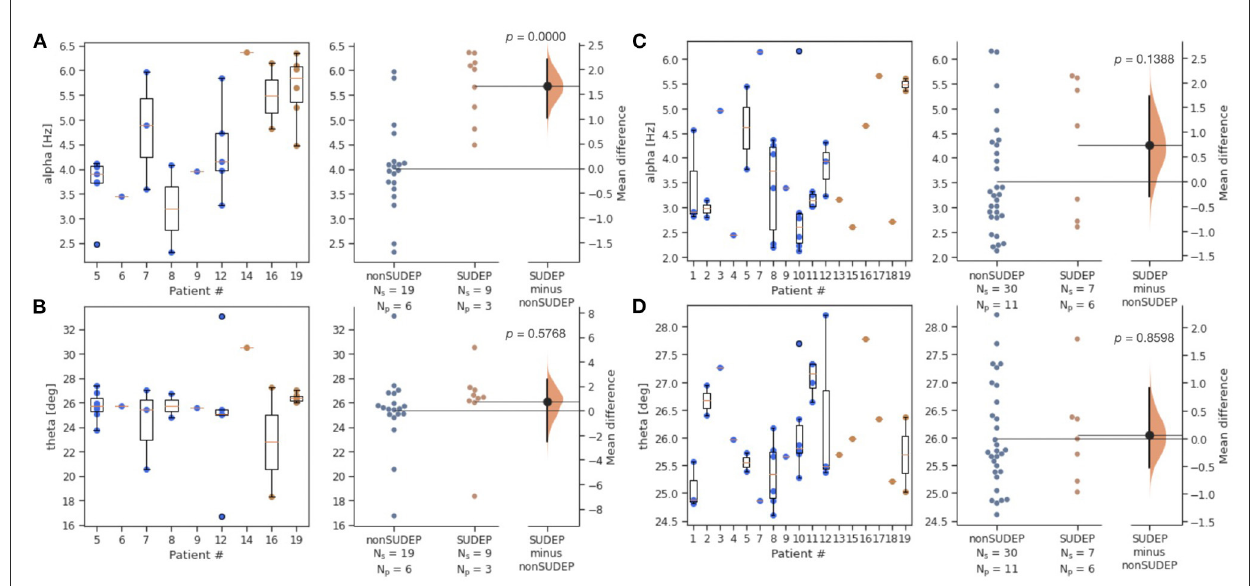
FIGURE3 Estimation statistics for alpha and theta metrics, by two seizure types (GTCS and non-GTCS). Patient number is consistent across all figures, however not all patients have both types of seizures. N s is number of seizures, N p is number of patients. Blue dots represent seizures from non-SUDEP patients. Orange dots represent seizures from SUDEP patients. Pink horizontal bars are mean values by patient. (A) Alpha for GTCS only. (B) Theta for GTCS only. (C) Alpha for non-GTCS only. (D) Theta for non-GTCS